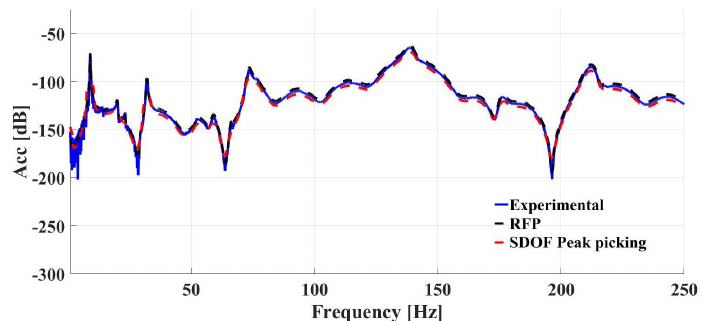
Figure 5. FRF of the acceleration measurements.